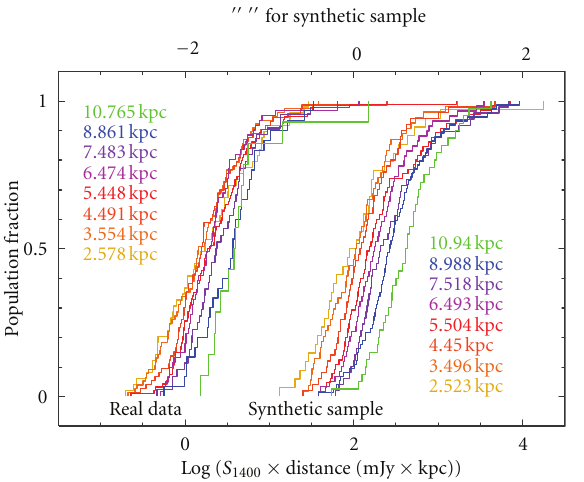
Figure 10: Left, lower horizontal axis: the population of 497 pulsars from the Parkes Multibeam Survey which fall into binned distances, with centers between ∼ 2.5 and ∼ 10.75 kpc, plotted against the log of the product of their 1400 MHz fluxes and their NE2001 distances from [69, 70]. Right, upper horizontal axis: the same for a synthetic distribution of pulsars which obey the inverse square law. The two families of curves are both in order of increasing distance from left to right at a population fraction of 0.2. Figure 11: Low frequency Fourier power from GRB 960216 (with